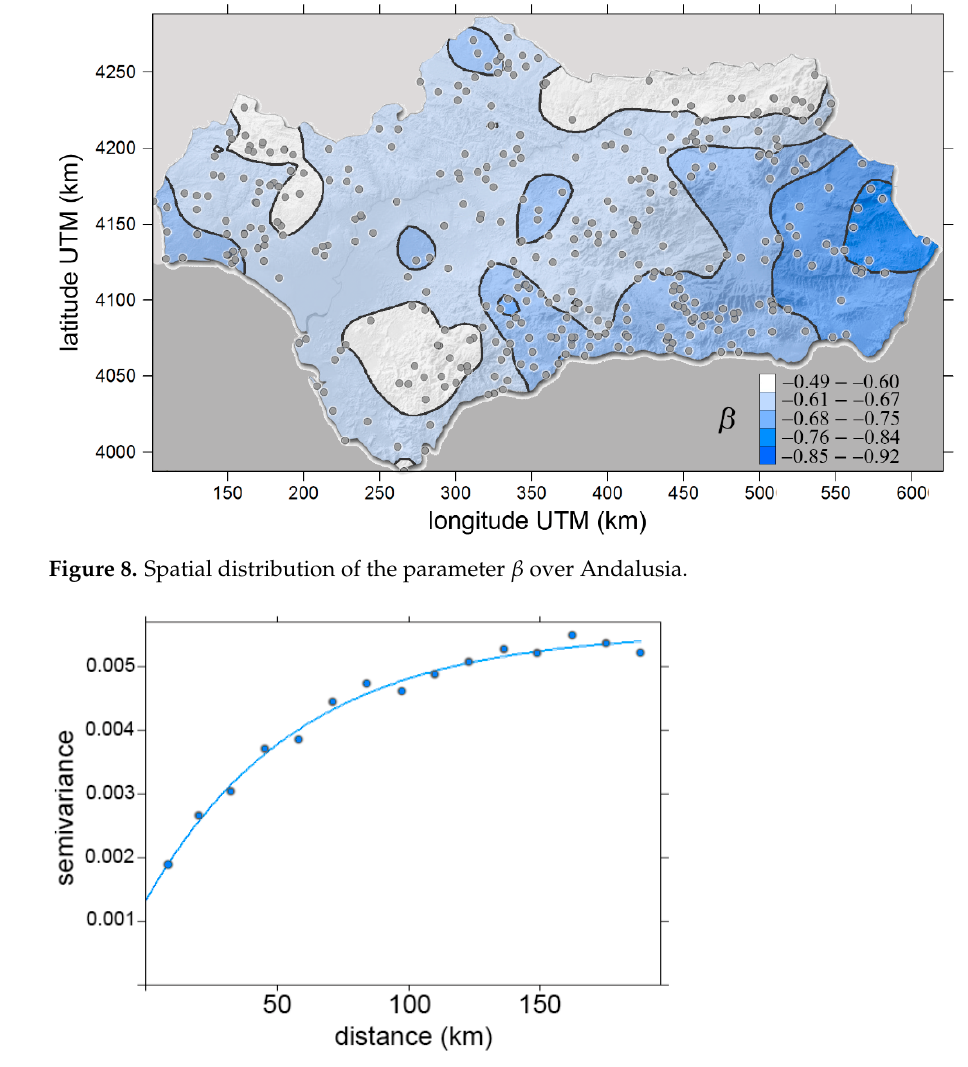
Figure 9. Kriging variogram.